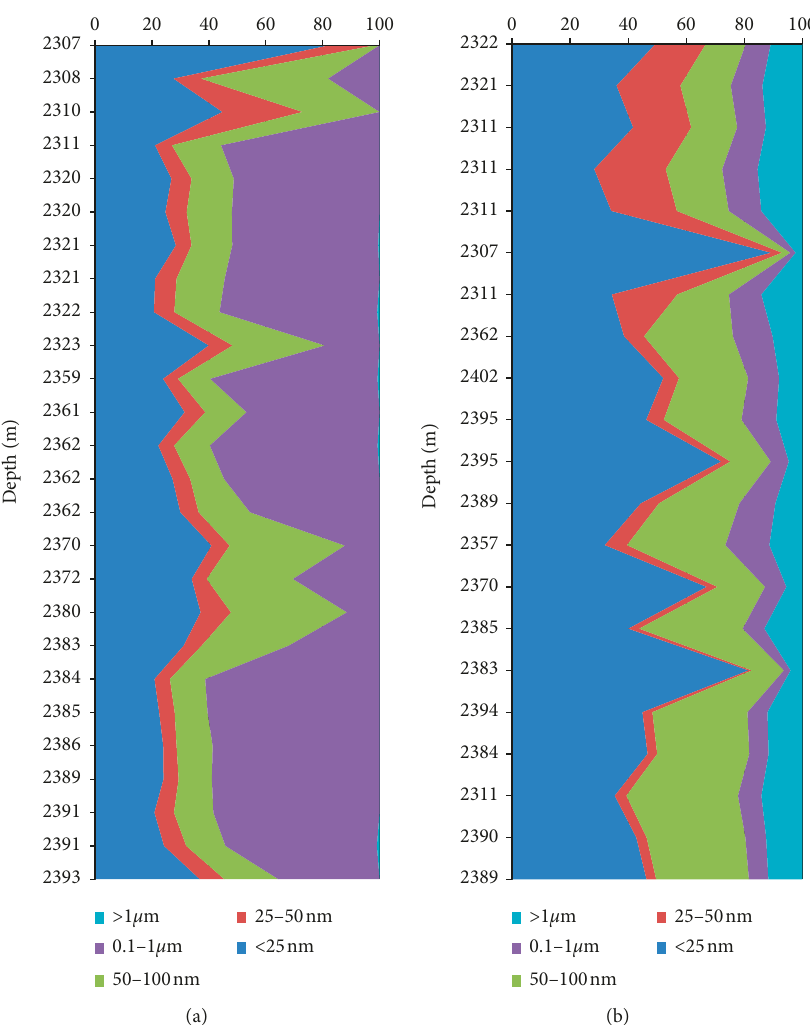
Figure 2: Pore distribution characteristics of tight reservoirs at different scales. (a) Pore distribution at different scales. (b) Fluid distribution in different pore